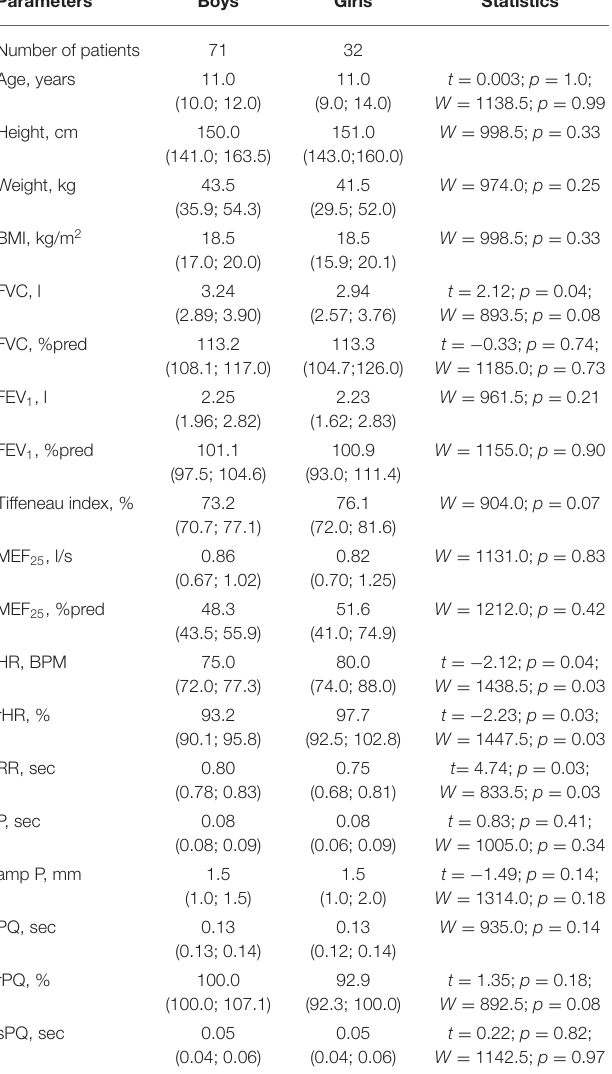
TABLE 1 | Clinical and functional characteristics of the examined BA patients. Parameters Boys Girls Statistics Number of patients